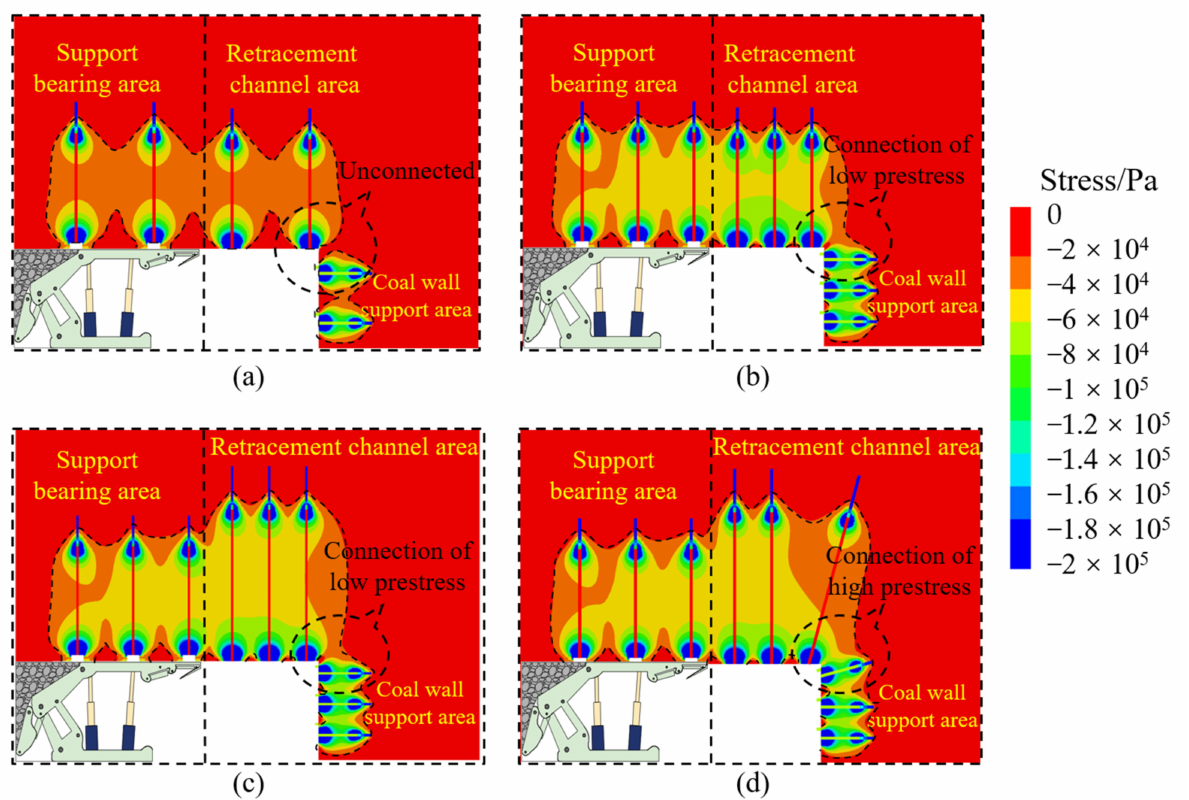
Figure 23. Schematic Diagram of Prestressing Field of Different Support Schemes ( a – d